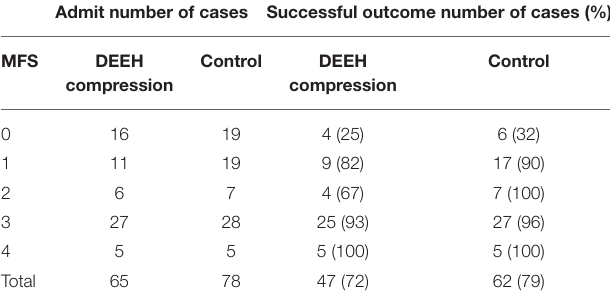
TABLE 1 | Modified Frankel Score distribution and successful outcome.